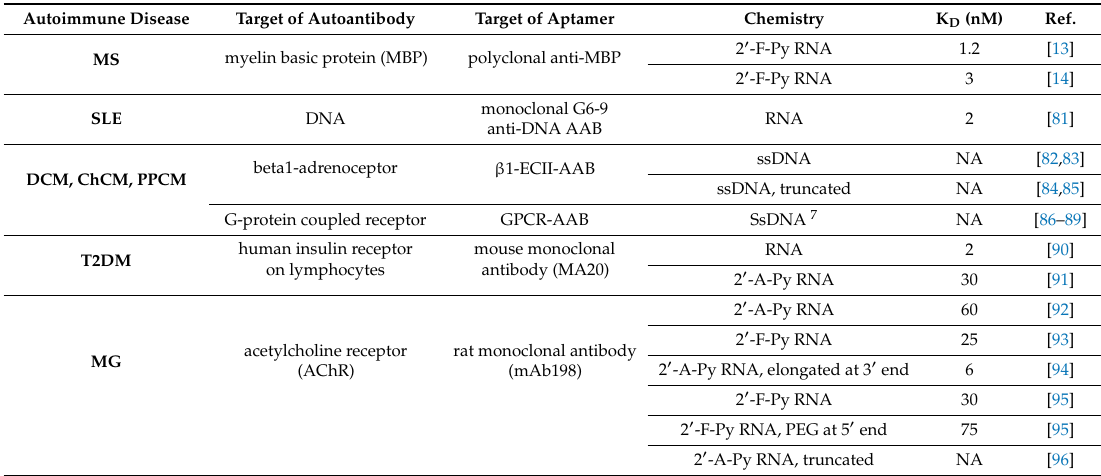
Table 6. Aptamers against di ff erent target autoantibodies, their chemical modification and K D values. Autoimmune Disease